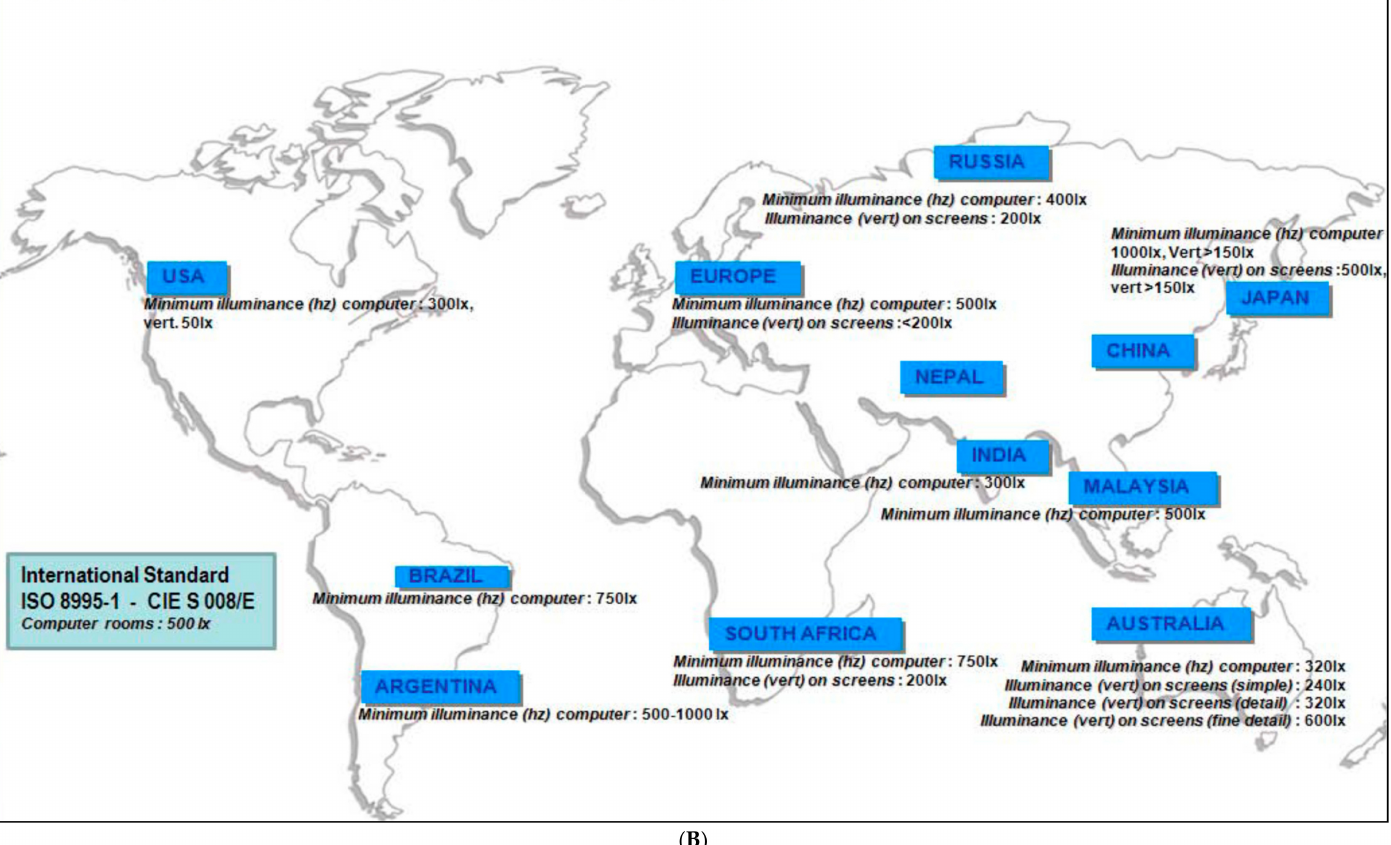
Figure A1. The minimum illuminance level based on International Standard ISO 8995-1:2002 (CIE 2001 / ISO 2002) for visual performance in o ffi ce ( A ) WPI horizontal for a drawing task ( B ) for a computer